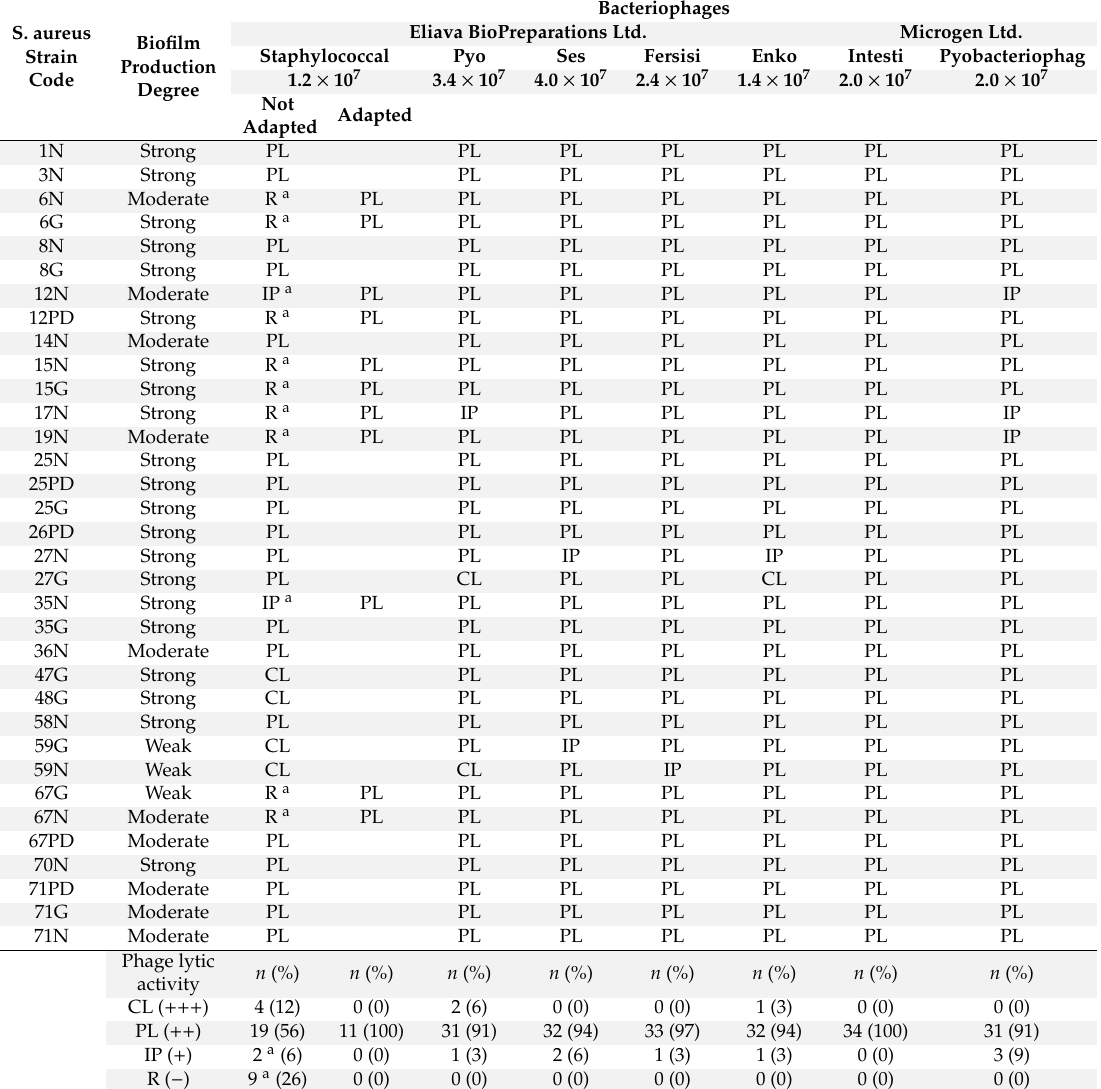
Table 3. Lytic activity of seven commercial bacteriophage cocktails against 34 Staphylococcus aureus strains acquired from peritoneal dialysis patient